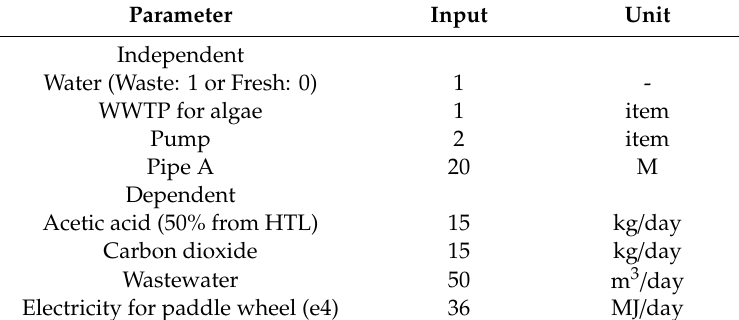
Table 5. Parameters set at cultivation sub-unit per 50 m 3 / day.